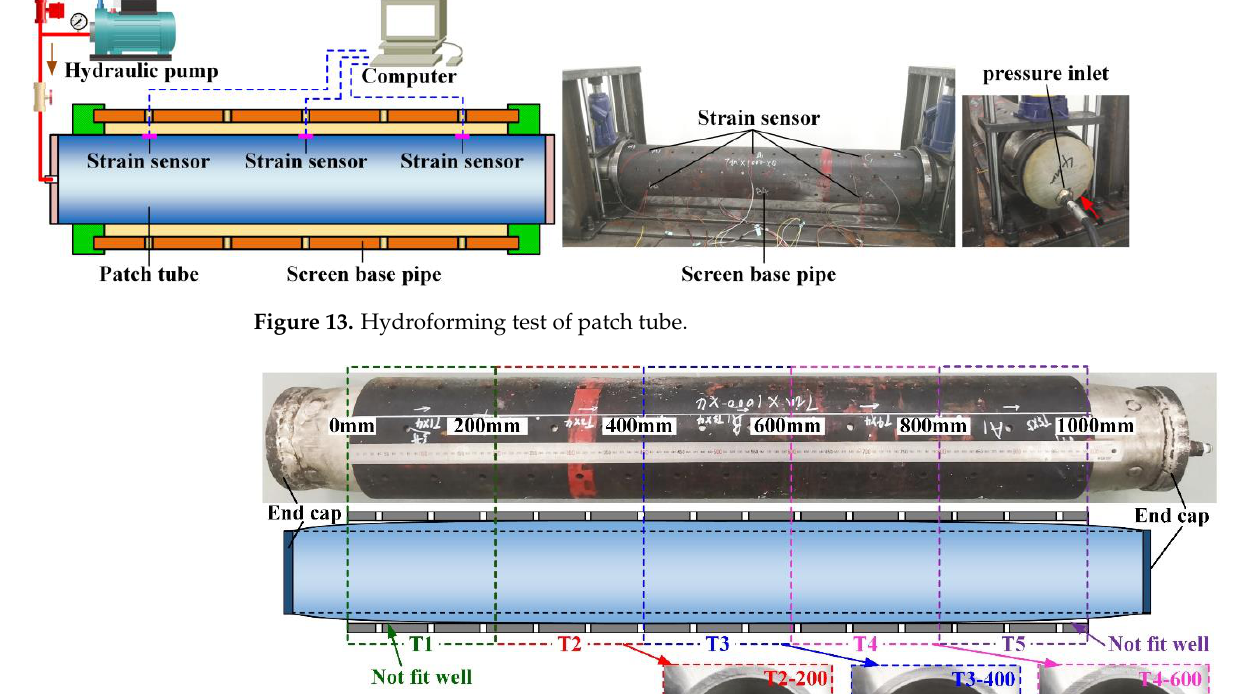
Figure 13. Hydroforming test of patch tube.